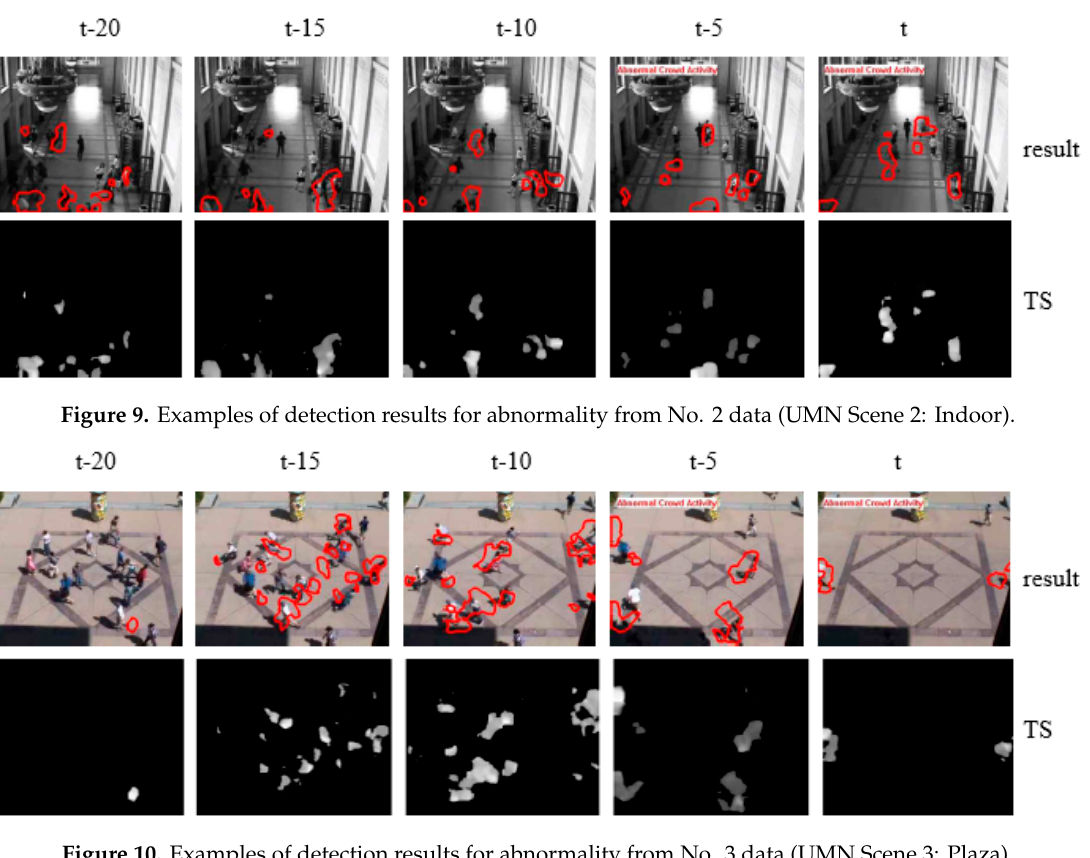
Figure 8. Examples of detection results for abnormality from No. 1 data (UMN Scene 1: Lawn).